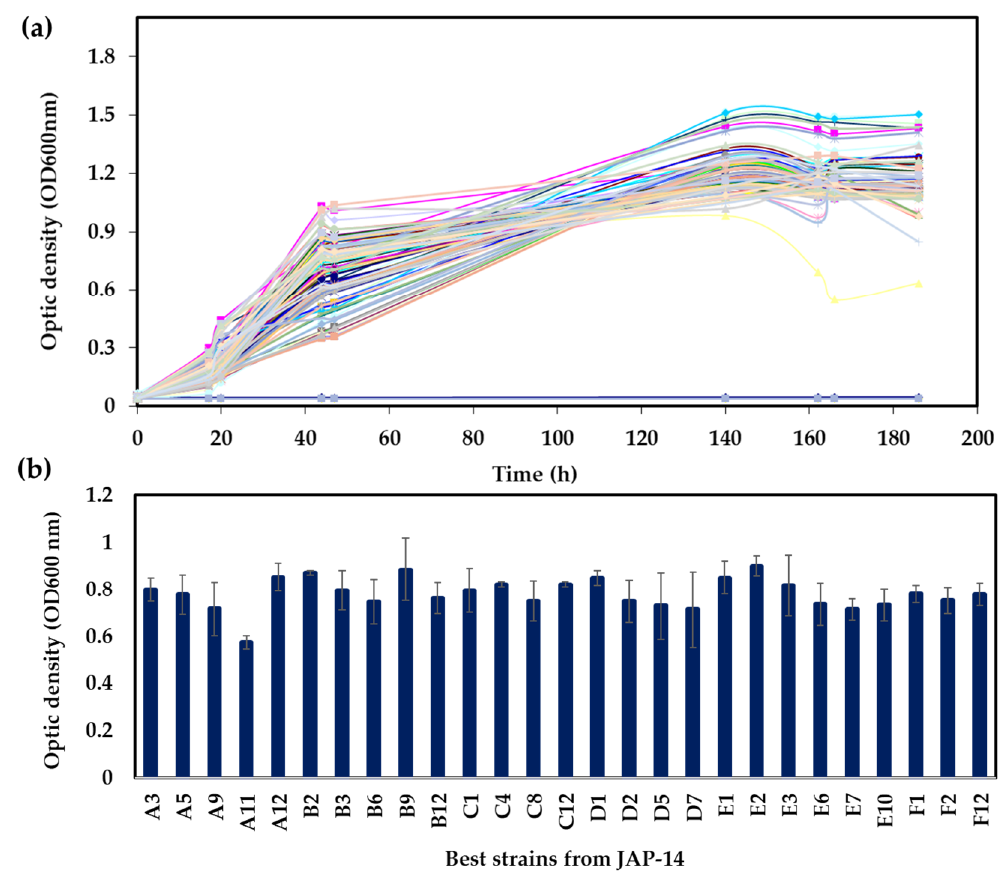
Figure 1. Selection of yeasts based on growth in xylose. ( a ) Growth profile of the 96 yeasts in defined medium. The colored lines represent the different strains of the plate JAP-14 ( b ) Final growth in 180 h for the 30 best strains in the microtiter plate JAP-14. Average and standard deviation for four replicates are shown.